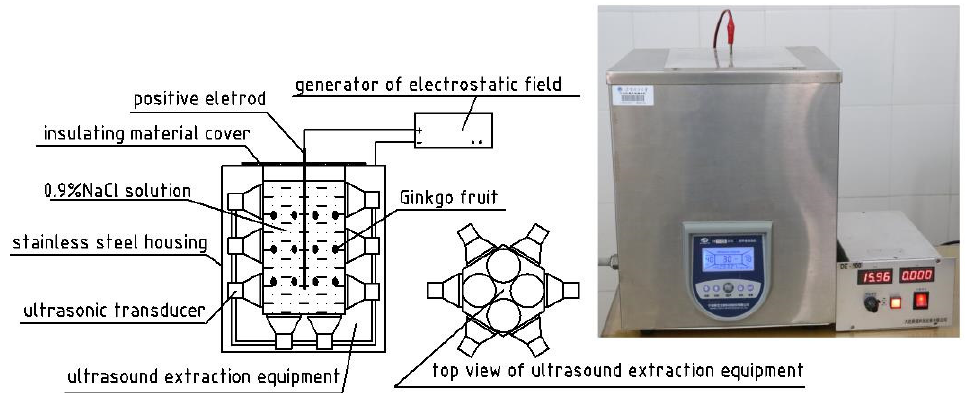
Figure 1. Schematic and physical diagram of the structure of the electrostatic field–ultrasonic coupling device.